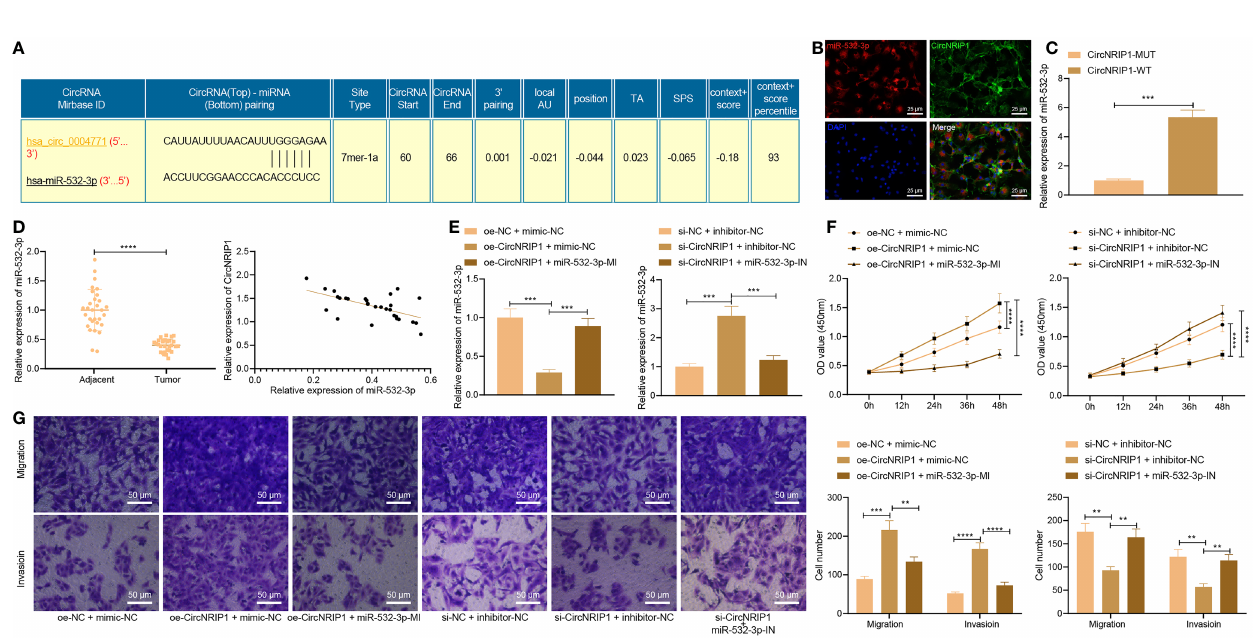
FIGURE 4 | circNRIP1 competitively binding to miR-532-3p, accelerating the malignant phenotype of osteosarcoma cells. (A) The predicted complementary binding sites between circNRIP1 (also known as hsa_circ_0004771) and miR-532-3p by the StarBase database. (B) Co-localization of circNRIP1 (labeled by FITC, green) and miR-532-3p (labeled by Cy3, red) in MG63 cells measured by FISH. The nucleus was stained blue by DAPI. (C) miR-532-3p pulled down by circNRIP1-WT or circNRIP1-MUT assessed by RNA pull-down assay. (D) Expression of miR-532-3p determined by RT-qPCR in adjacent normal and osteosarcoma tissues (the left), and the correlation of miR-532-3p with circNRIP1 analyzed by Pearson ’ s correlation coef fi cient in osteosarcoma tissues (the right). (E) Expression of miR-532-3p determined by RT-qPCR in MG63 cells treated with oe-circNRIP1, si-circNRIP1, oe-circNRIP1 + miR-532-3p mimic, or si-circNRIP1 + miR-532-3p inhibitor. (F) Proliferation of MG63 cells treated with oe-circNRIP1, si-circNRIP1, oe-circNRIP1 + miR-532-3p mimic, or si-circNRIP1 + miR-532-3p inhibitor measured by CCK-8. (G) Migration and invasion of MG63 cells treated with oe-circNRIP1, si-circNRIP1, oe-circNRIP1 + miR-532-3p mimic, or si-circNRIP1 + miR-532-3p inhibitor measured by Transwell assay. ** p < 0.01. *** p < 0.001. **** p < 0.0001. Data are shown as mean ± standard deviation of three technical replicates. Data between osteosarcoma tissues and adjacent normal tissues were compared using paired t -test and those between the other two groups by unpaired t -test. Data among multiple groups were compared with one-way ANOVA, followed by Tukey ’ s post hoc tests. The repeated measures ANOVA with Bonferroni post hoc test was applied for the comparison of data at different time